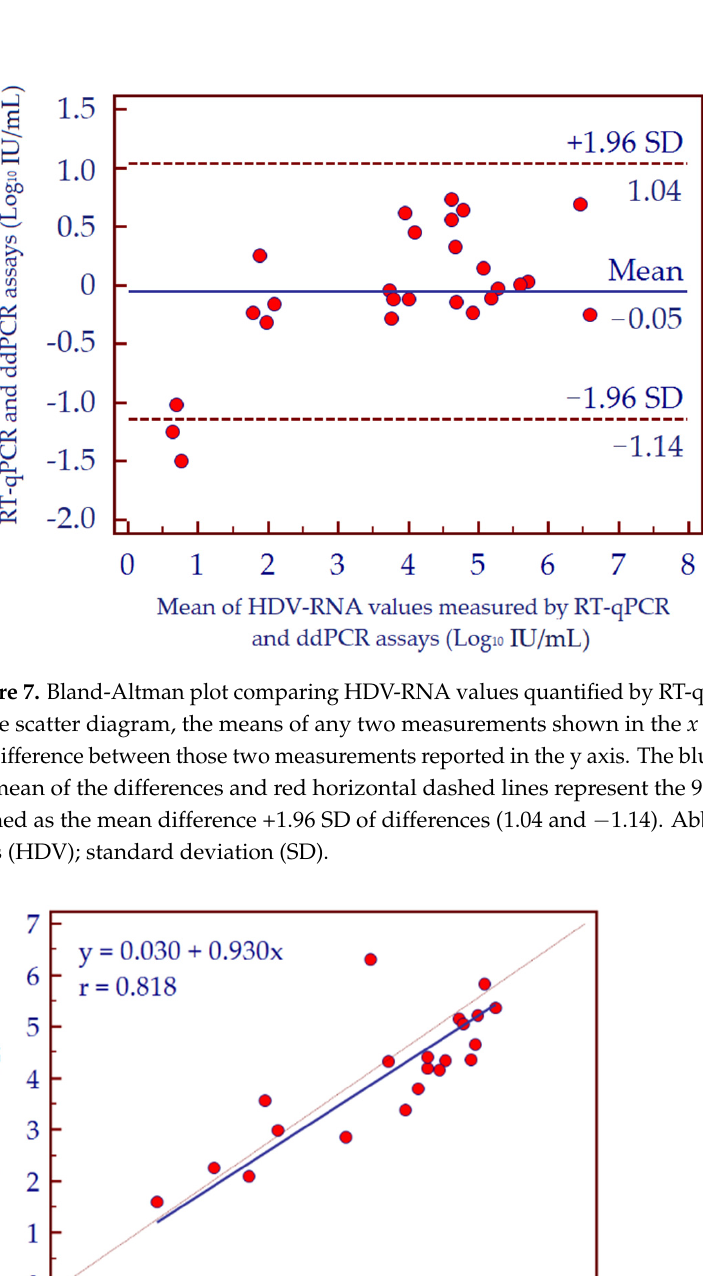
Figure 8. Deming regression analysis of HDV-RNA viral loads of 20 clinical specimens determined by ddPCR and RoboGene HDV RNA Quantification Kit 2.0.